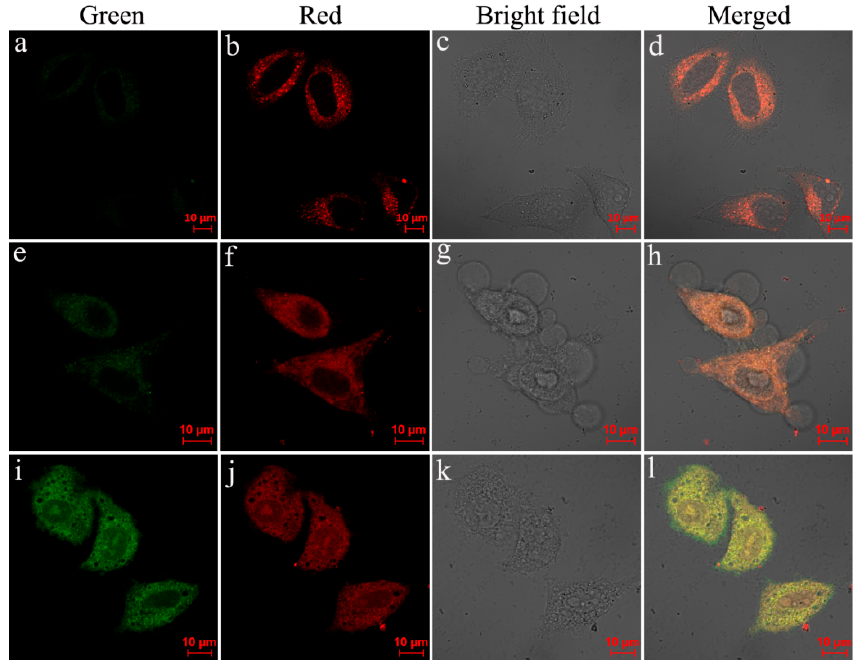
Figure 5. Confocal fluorescence images of living HeLa cells ( a – d ) incubated with 10 μ M BPO-DNSP ; ( e – h ) HeLa cells pretreated with 50 μ M NEM and further incubated with 10 μ M BPO-DNSP ; ( i – l ) after pretreatment with 50 μ M NEM, HeLa cells were loaded with 10 μ M BPO-DNSP and then incubated with SO 2 (500 μ M) in the green channel, red channel, bright-field, and merged images. For green channel: λ ex = 405 nm, λ em = 460–530 nm; for red channel: λ ex = 560 nm, λ em = 620–720 nm.